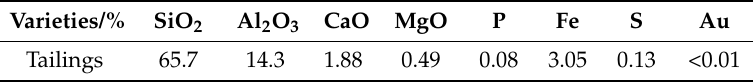
Table 1. Chemical components of the studied